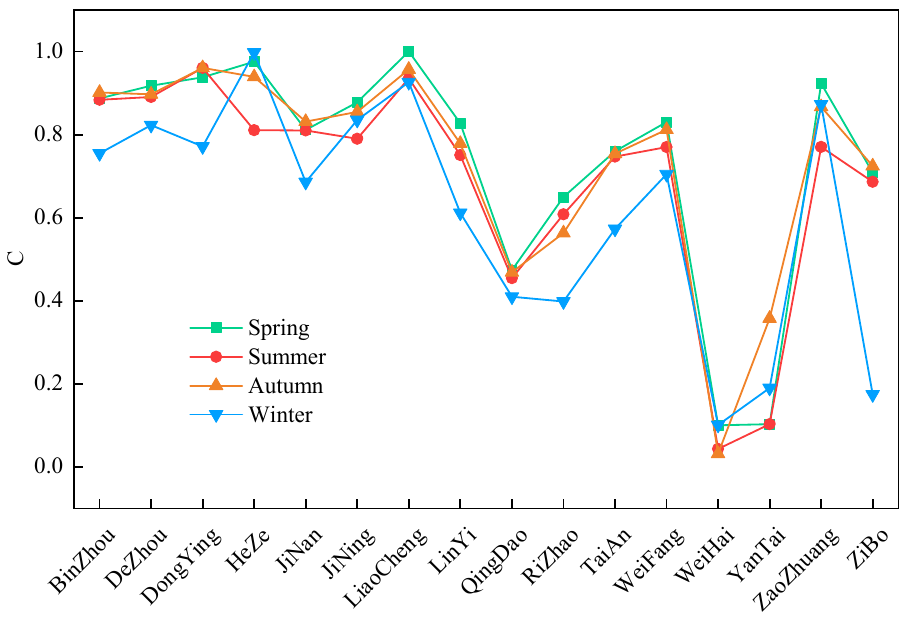
Figure 6. Seasonal change of coupling coordination degree of cities in Shandong Province.